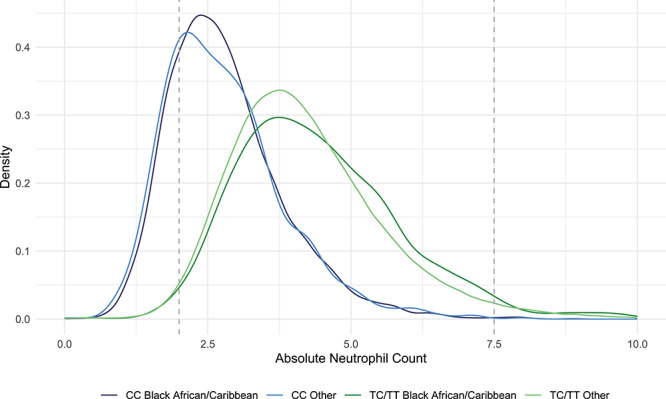
Neutrophil count in individuals with the CC (Duffy-null) and TC/TT genotypes at rs2814778. Density plot of absolute neutrophil count (ANC) in individuals with the CC (Duffy-null) and TC/TT genotypes at rs2814778 and self-reported ethnicity in UK Biobank participants. Other category includes all self-reported ethnicities other than Black African/Caribbean. The dotted grey lines represent the current UK thresholds for the normal adult range of ANC (2.0–7.5 × 109/L).